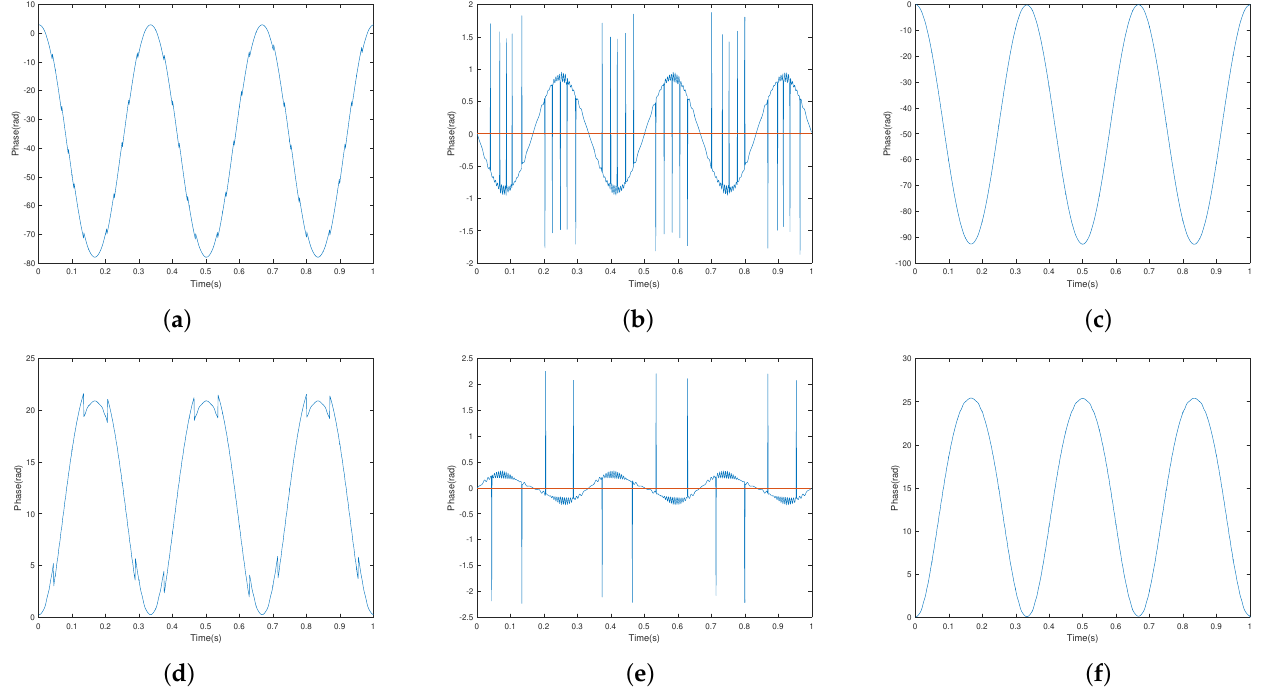
Figure 6. Ambiguous phase extraction: ( a ) Doppler phase corresponding to the envelope of the cone- top point scatterer; ( b ) the difference between two adjacent pulse of ( a ); ( c ) phase after compensation of ( a ); ( d ) Doppler phase corresponding to the envelope of the cone-bottom point scatterer; ( e ) the difference between two adjacent pulse of ( d ); ( f ) phase after compensation of ( d